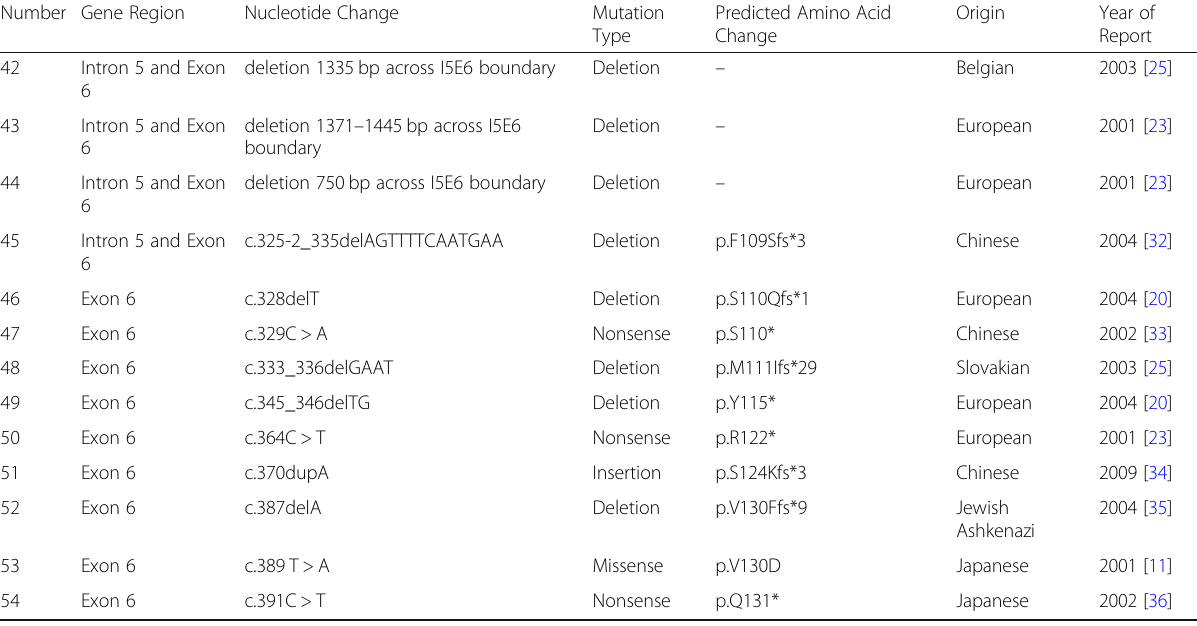
Table 1 Summary of identified pathogenic variants in the TRAPPC2 gene (Continued)